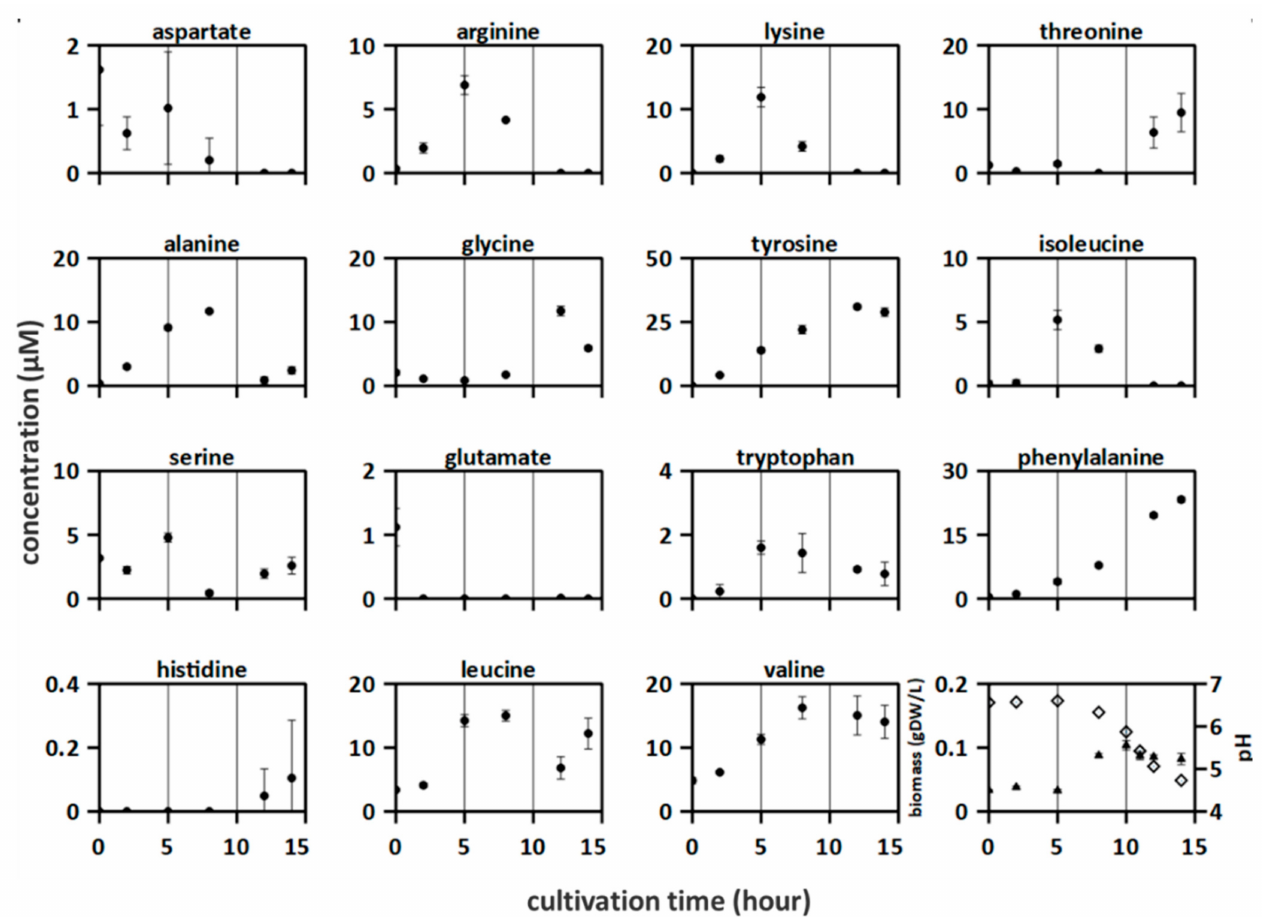
Figure 2. Amino acid concentrations were measured in proteinase-positive S. thermophilus ST.1 culture in synthetic medium supplemented with casein (SMcas). The lines indicate three phases according to the growth. Downright: biomass (triangle) and pH (rhomb)